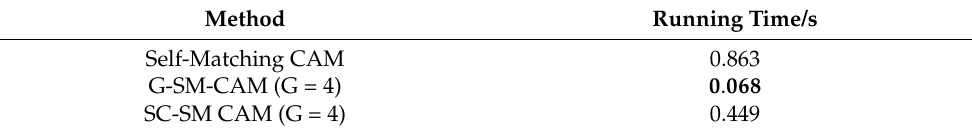
Table 3. Average running time of each CAM method.